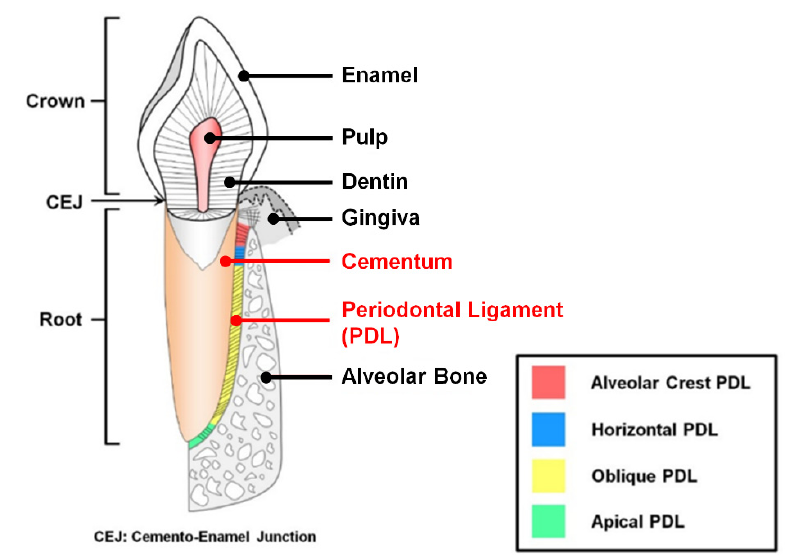
Figure 1. Illustration of tooth structure and tooth-supportive complex. Four different types of periodontal ligament (PDL) fibers are typically categorized between the cementum on the tooth-root surface and the alveolar bone. Adapted with permission from the reference [8].